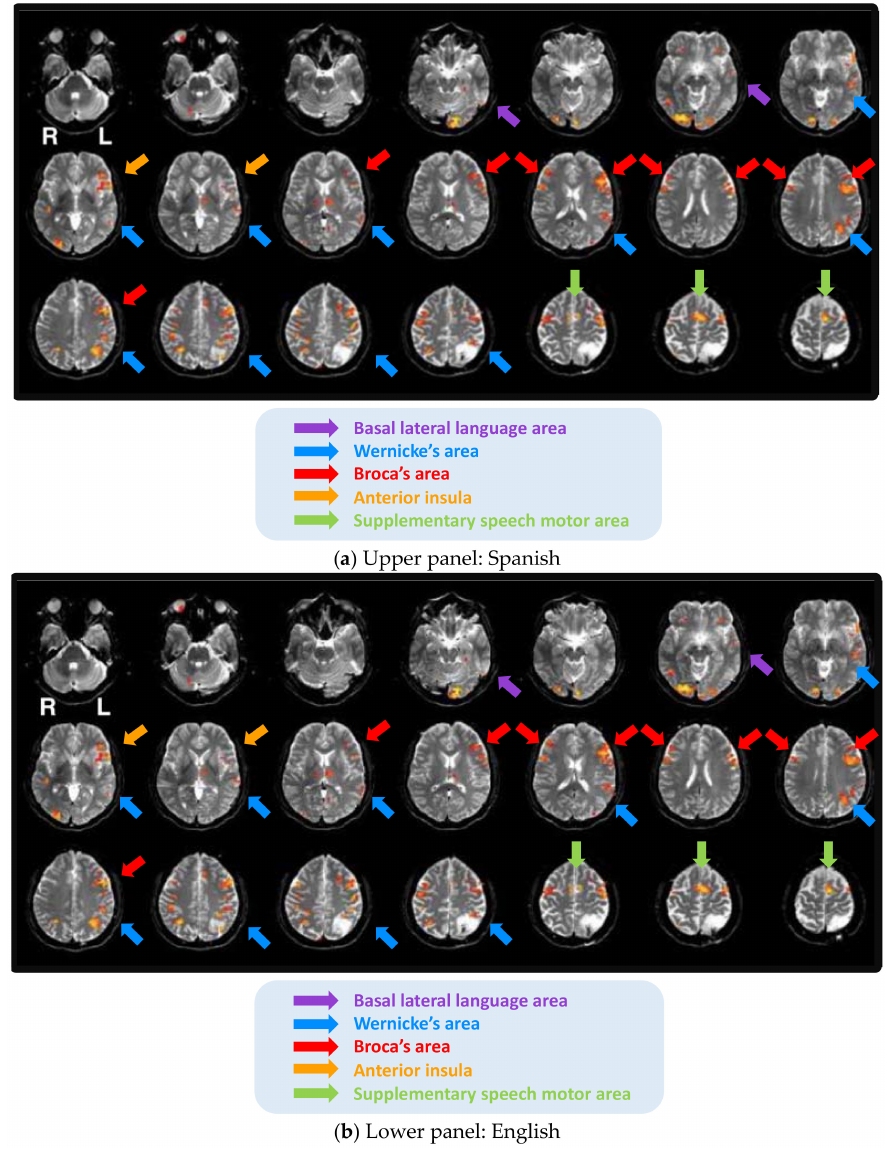
Figure 3. Language activity in Spanish and English in Case